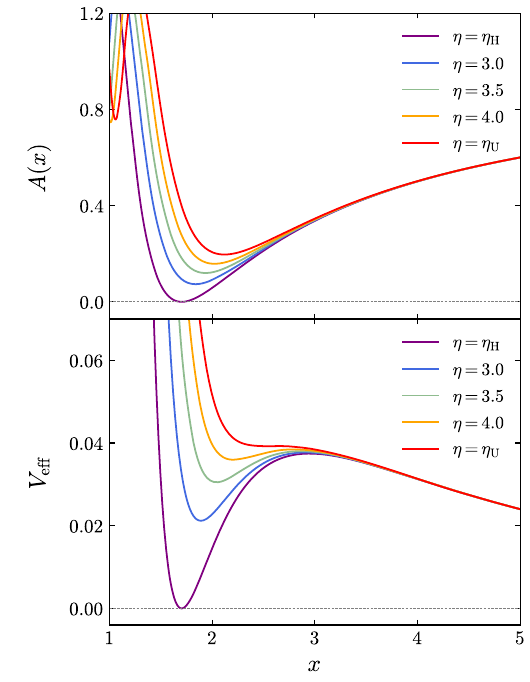
Fig. 3 A ( x ) (top) and V eff (bottom) with respect to x fro some η